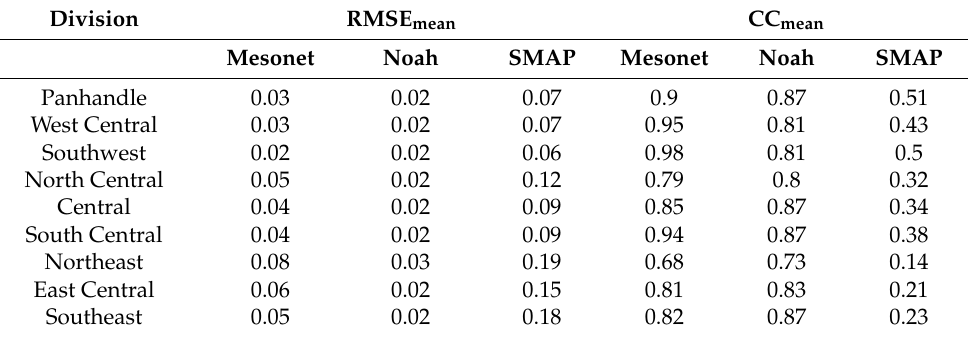
Table 7. Climate-division averaged CC and RMSE from the TC triplets at local 6:00 a.m. values from April 2015 to July 2019, for Mesonet, Noah, and SMAP during the fall season months (i.e., September, October, and November) for nine climate divisions in